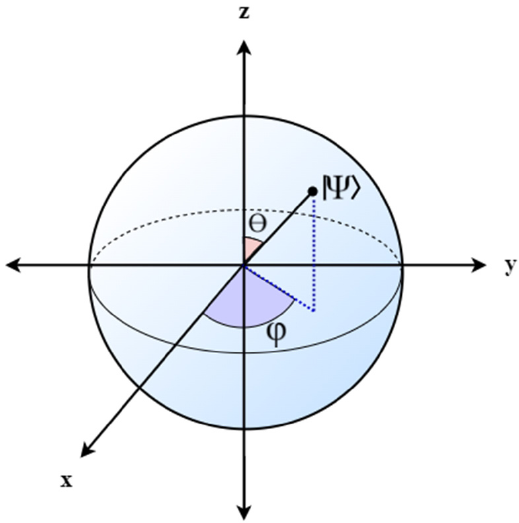
Figure 2. A qubit | ψ (cid:105) represented as a point in the unitary Bloch Sphere. Note from Equation (8) that, Figure 2. A qubit |𝜓⟩ represented as a point in the unitary Bloch Sphere. Note from Equation (8) for θ = 0 or θ = π , the qubit is located at the north and south poles, which coincides with the | 0 (cid:105) or that, for 𝜃 = 0 or 𝜃 = 𝜋 , the qubit is located at the north and south poles, which coincides with | 1 (cid:105) states, respectively. Another important case is θ = π (cid:3095) , where the qubit is located exactly in the , where the qubit is located the |0⟩ or |1⟩ states, respectively. Another important case is 𝜃 = 2 (cid:2870) equatorial surface of the sphere, representing a perfect superposition of both basal states. (Adapted from